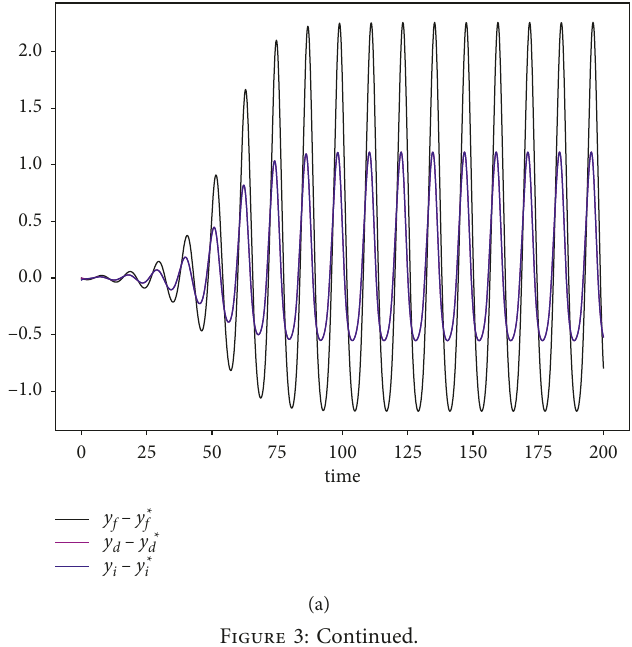
Figure 2: The 3D phase portrait. (a) Phase portrait projected on the y portrait projected on the k f − k d − k i space in black and the transformed one in